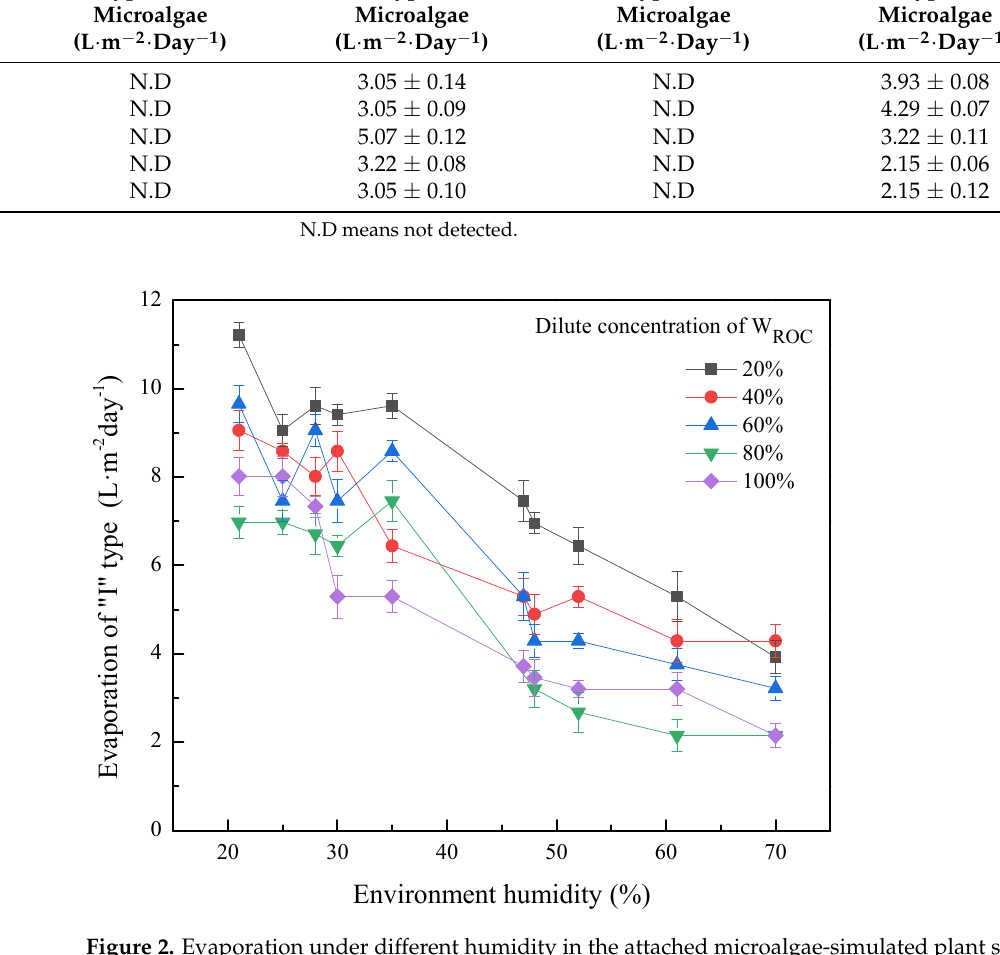
Table 2. W ROC evaporation rates of different attached microalgae-simulated plants under the relative humidity of 70%. Dilution Con- centration of W ROC